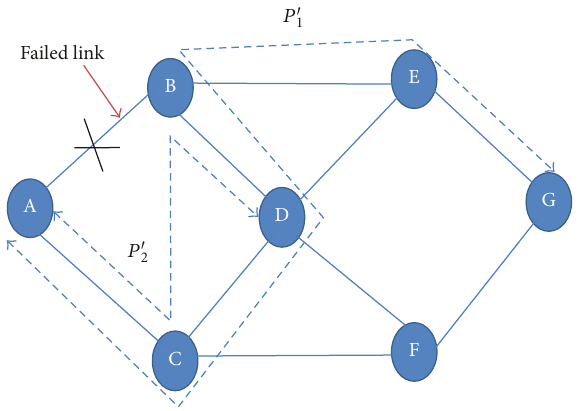
Figure 3: A depiction of a link failure and a corresponding path